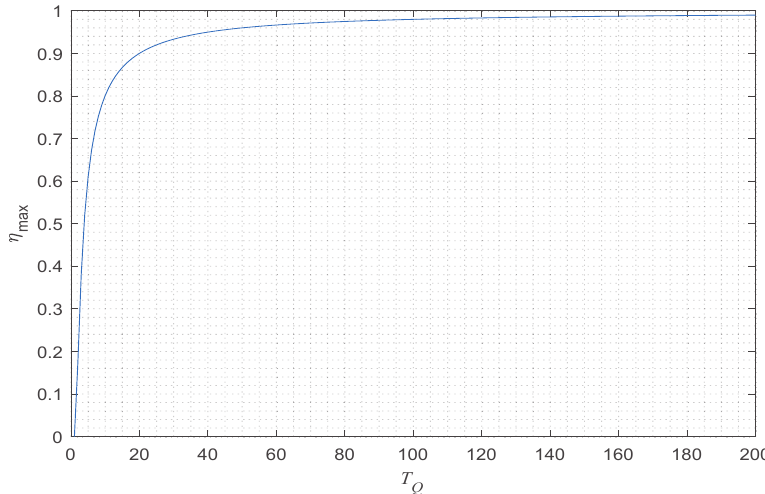
Figure 2. Theoretical maximum transfer efficiency varying with T Q .